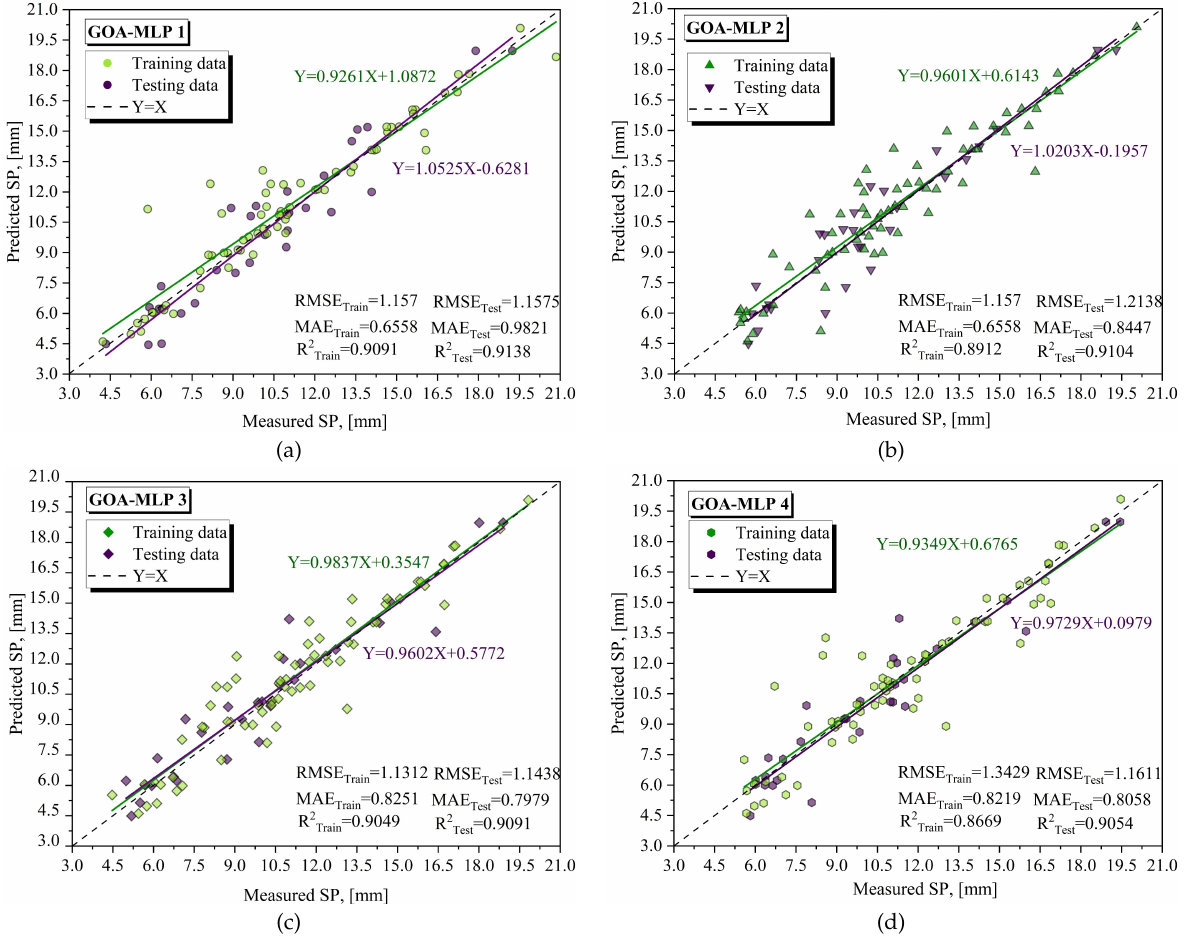
Fig. 9. Comparison between measured and predicted pile settlement for GOA-MLP models owns the weakest performance between developed hybrid MLP models, despite performance itself having satisfactory workability in predicting